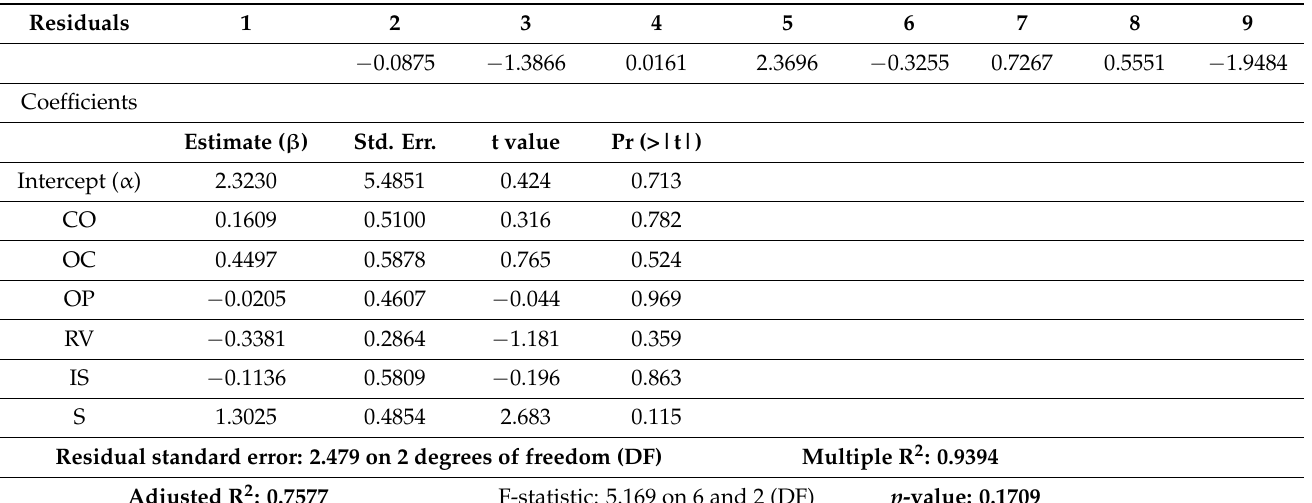
Table 5. Results of multiple linear regression of initial model.